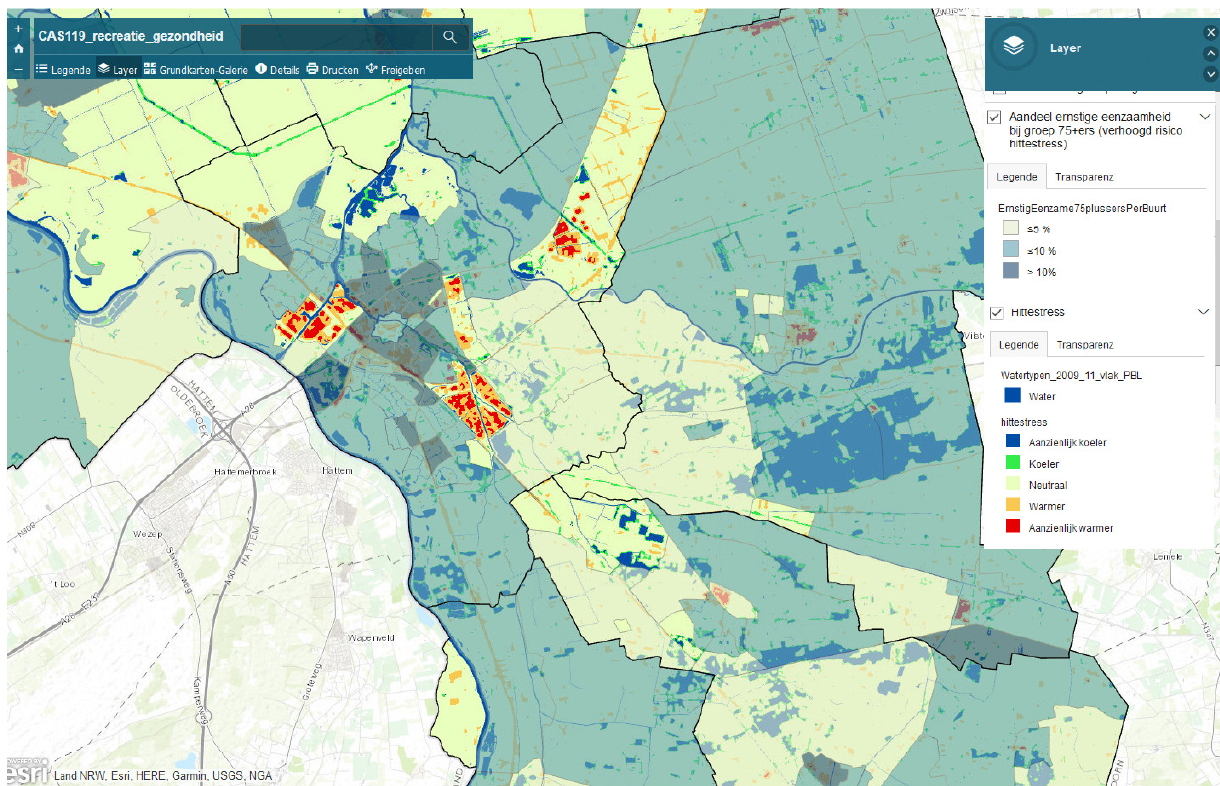
Figure 3. RIVUS region: Overlay of climate stressors and sensitivity, example heat, and population. Source: Foundation Climate Adaptation Services (n.d.‐b).